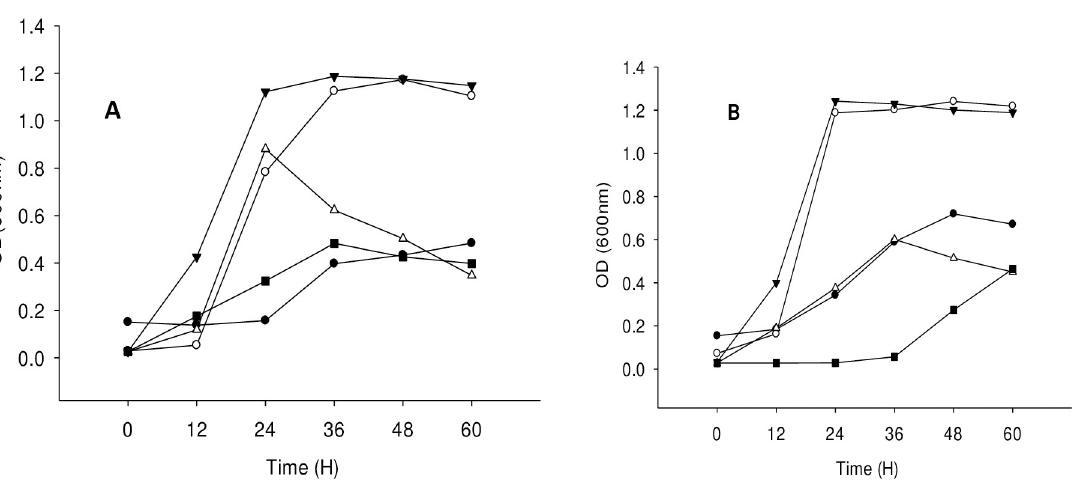
Fig 3. Proliferation of the strains under different temperature; (A) Acinetobacter toweneri NTA1-2A, (B) Acinetobacter guillouiae TAT1-6A. Symbols: solid circle, 25˚C; open circle, 28˚C; solid triangle, 31˚C; open triangle, 34˚C; solid square, 37˚C at pH 6 and 1 mM of 3MI